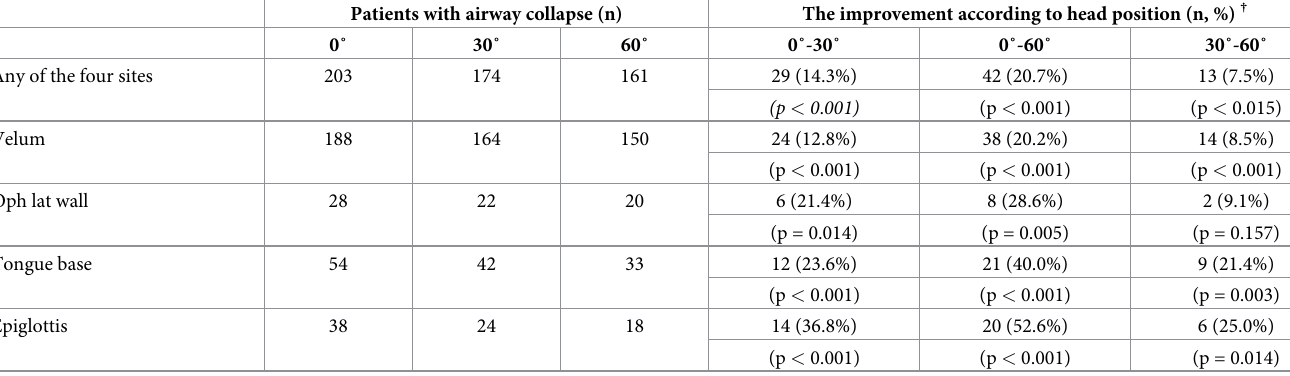
Table 2. Number of patients with airway obstruction according to the degrees of head rotation � .